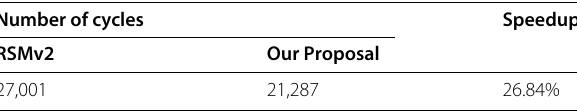
Table 5 Speedup on an ATmeaga 163 micro-processor running at 8MHz Number of